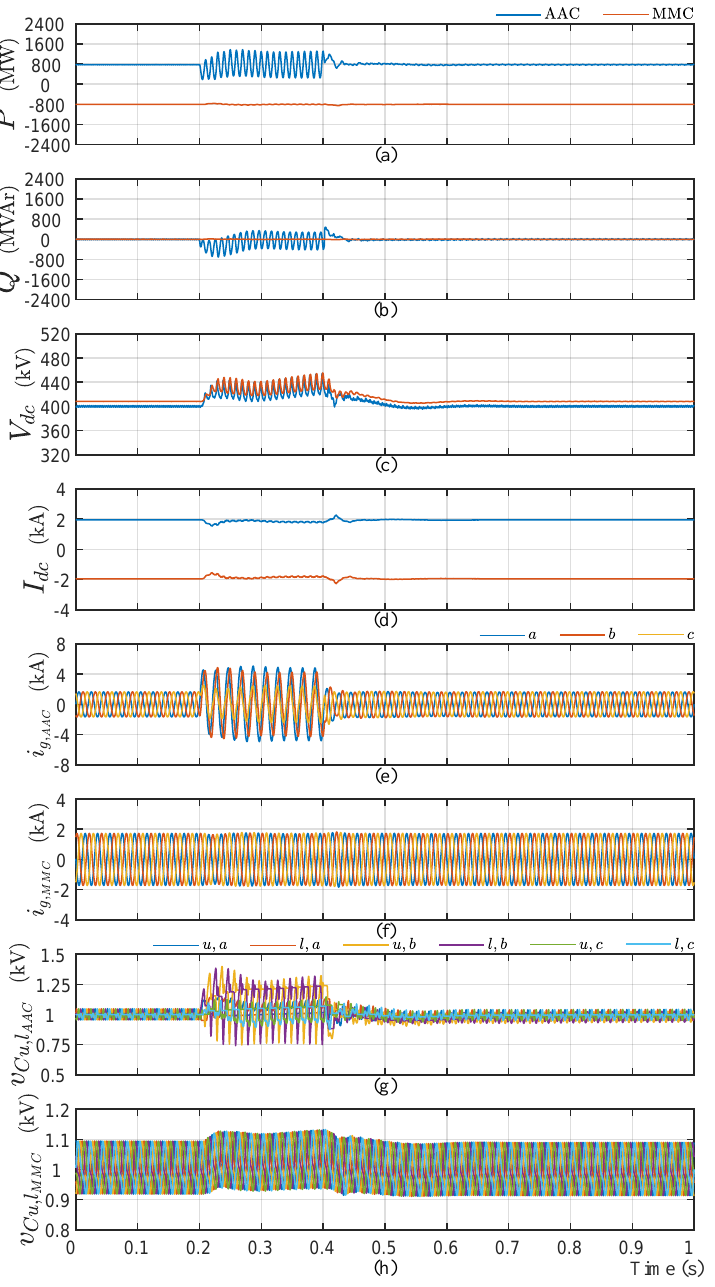
Figure 9. AAC Single phase-to-ground fault at 0.2 s: ( a ) active power, ( b ) reactive power, ( c ) dc- voltage, ( d ) dc-current, ( e ) ac currents of AAC, ( f ) ac currents of MMC, ( g ) SM capacitor voltages of AAC, and ( h ) SM capacitor voltages of